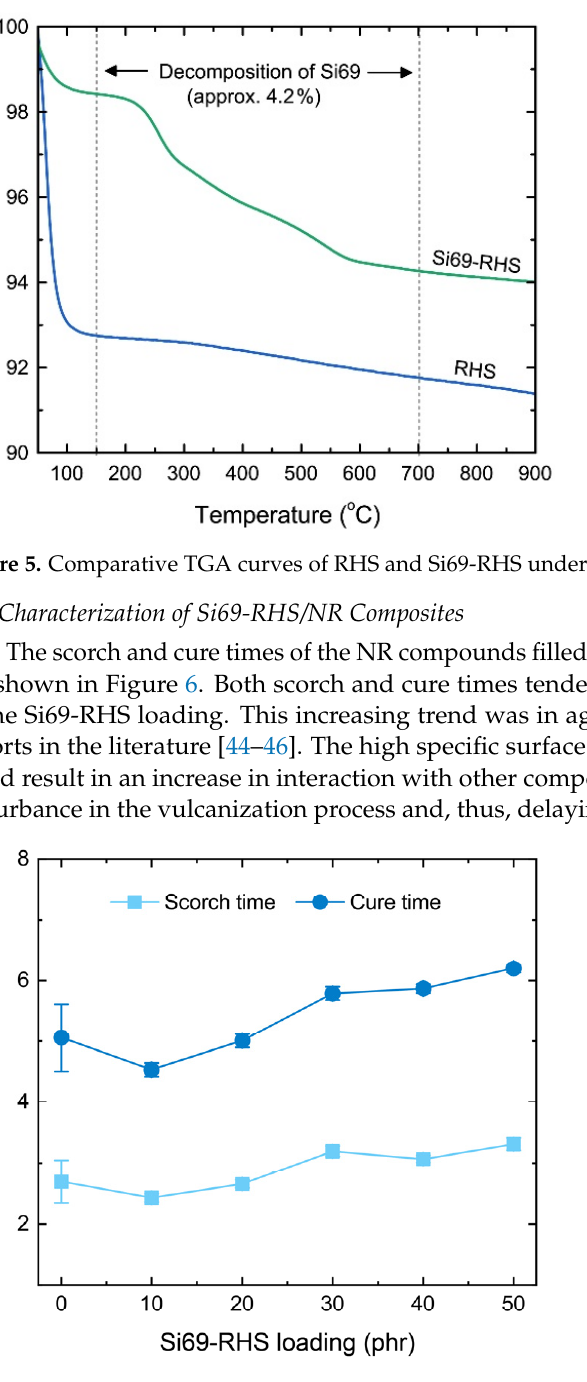
Figure 6. Scorch and cure times of the NR compounds filled with various Si69-RHS loadings.